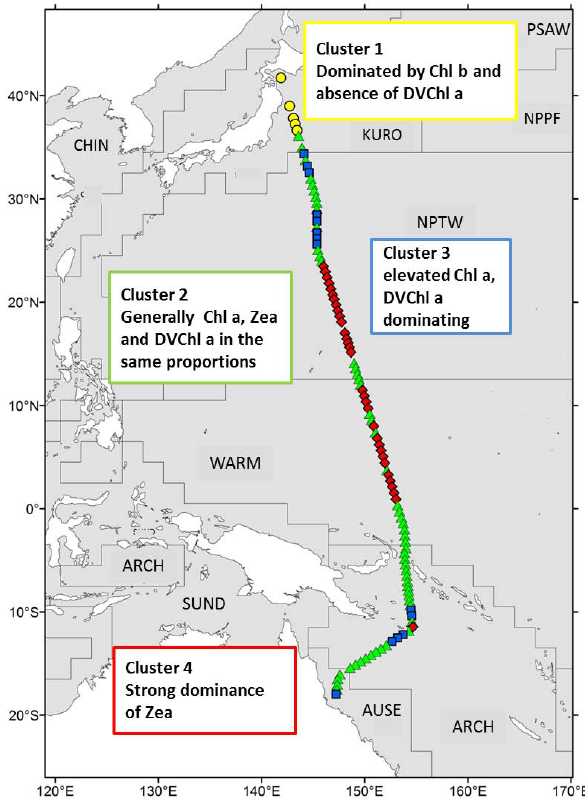
Fig. 3. Distribution of clusters among pigment stations with the Longhurst provinces shown underneath. Yellow indicates cluster 1 (circles), green is cluster 2 (triangles), blue is cluster 3 (squares), and red is cluster 4